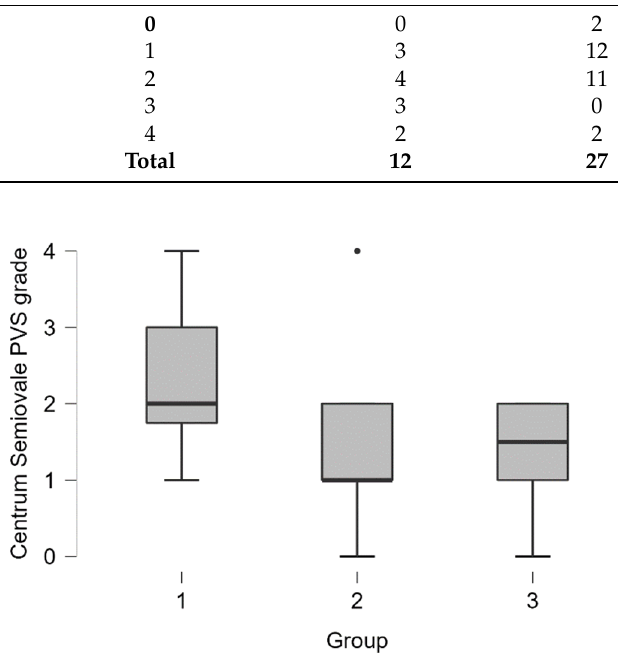
Table 3. Centrum Semiovale PVS grade dilatation in dementia, MCI and normal cognition groups. Group Centrum Semiovale PVS